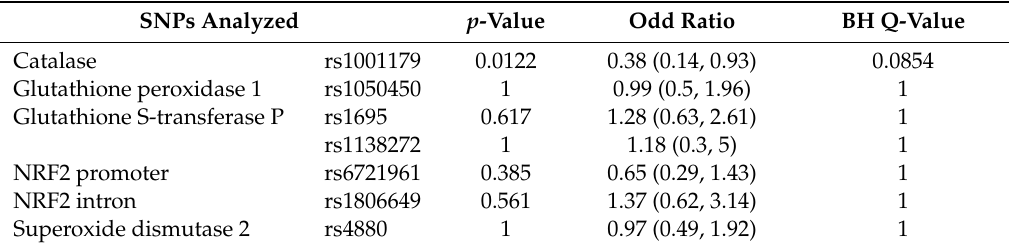
Table 2. Single nucleotide polymorphisms (SNPs) analyzed for association with disease severity. SNPs